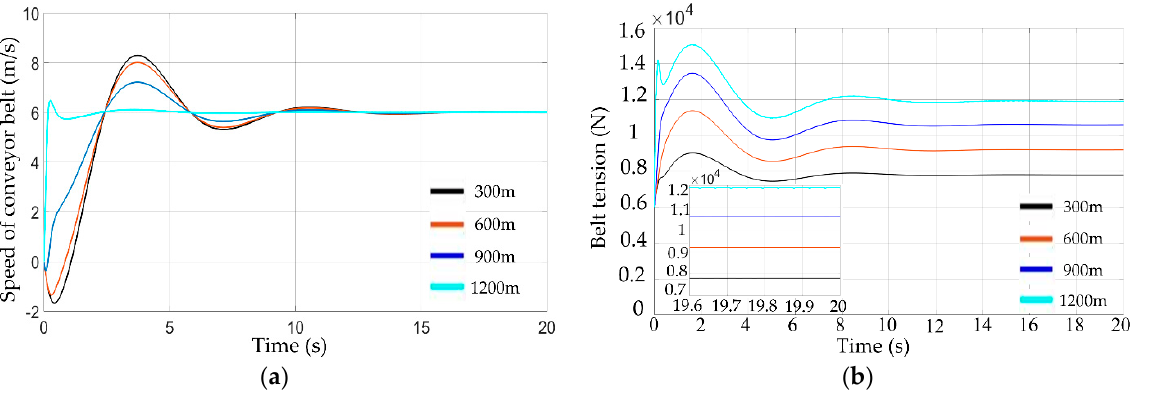
Figure 9. Conveyor belt response curve of traditional belt conveyor system under light load opera-